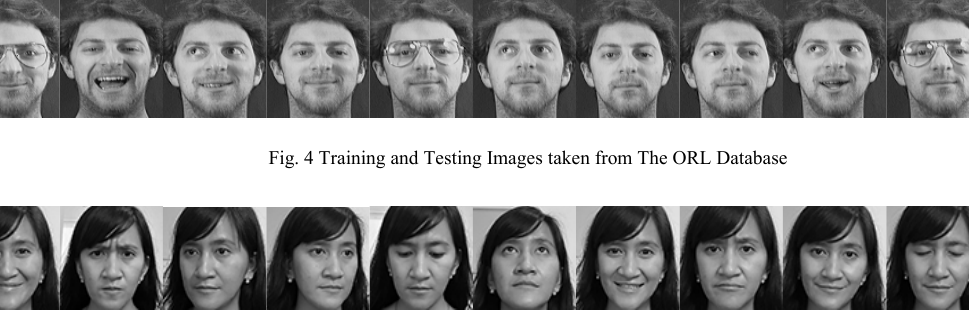
Fig. 5 Training and Testing Images taken from Web